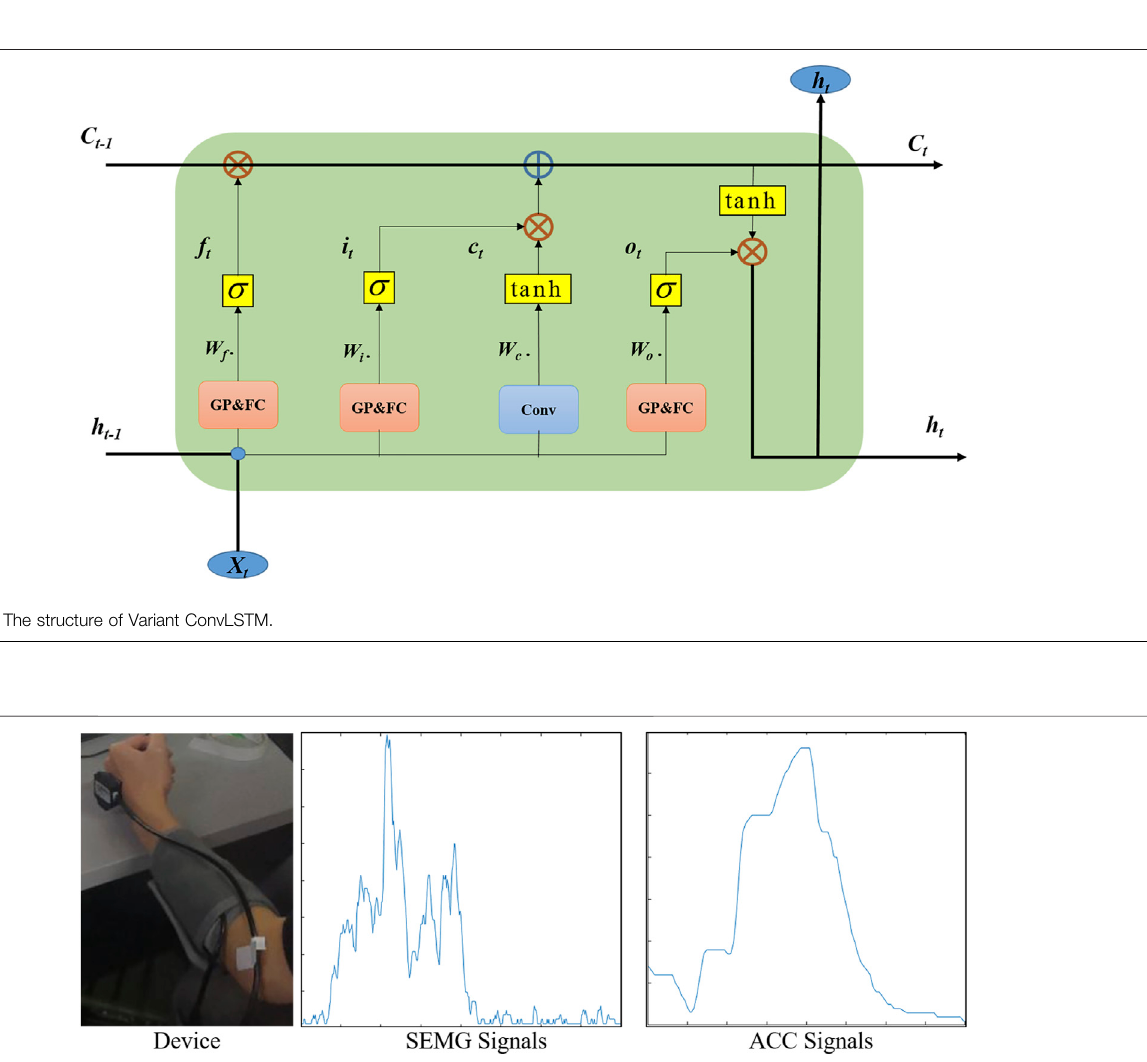
FIGURE 6 | Signal acquisition diagram.